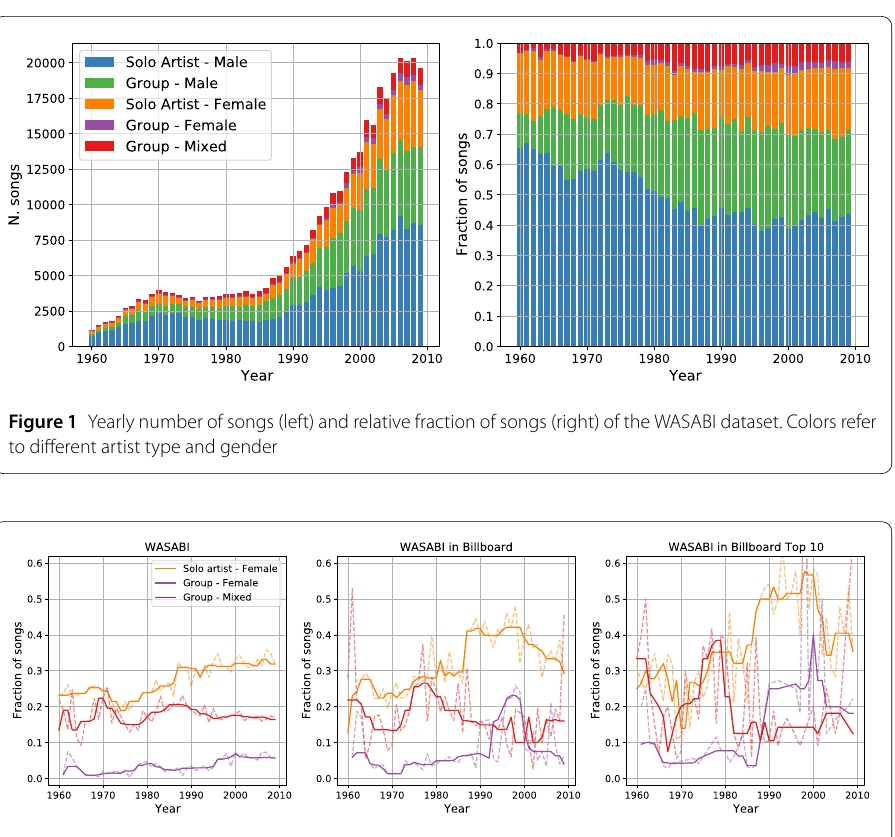
Figure 2 Yearly fraction of songs by female solo artists, female groups, and mixed groups. The three plots refer to the (filtered) WASABI dataset (left), songs in Billboard charts (center), and songs reaching Billboard top 10 (right). Dashed lines are raw fractions of songs, solid lines a median filter with window = 5 years. Two data points in Billboard top 10 are out of the figure’s